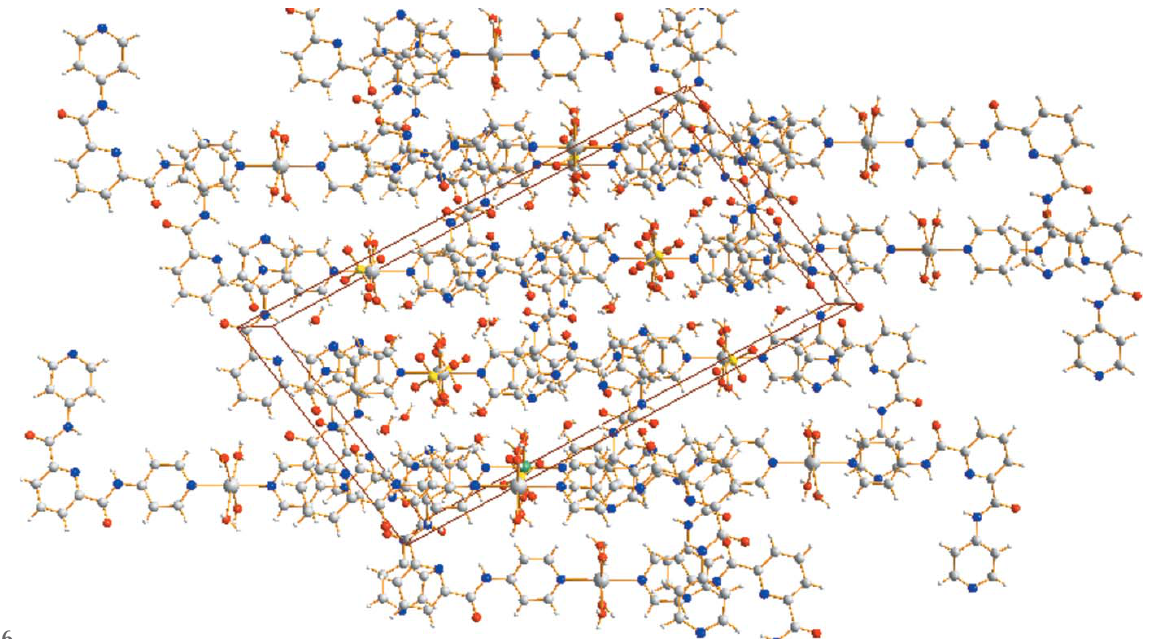
Figure 6 The molecular packing of (II) viewed along the b axis.